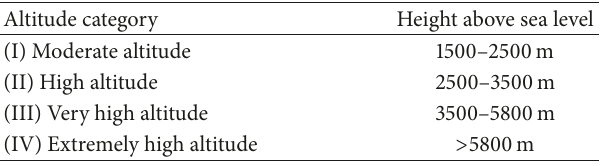
Table 1: Categorization of